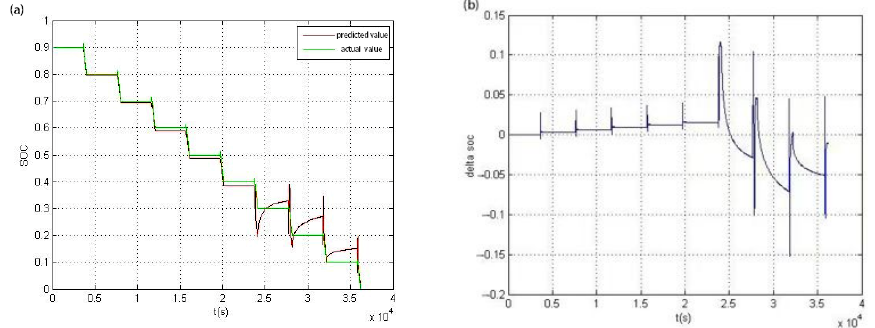
Figure 11. Comparison chart of ( a ) predicted SOC and actual value; ( b ) the difference through HPPC test.